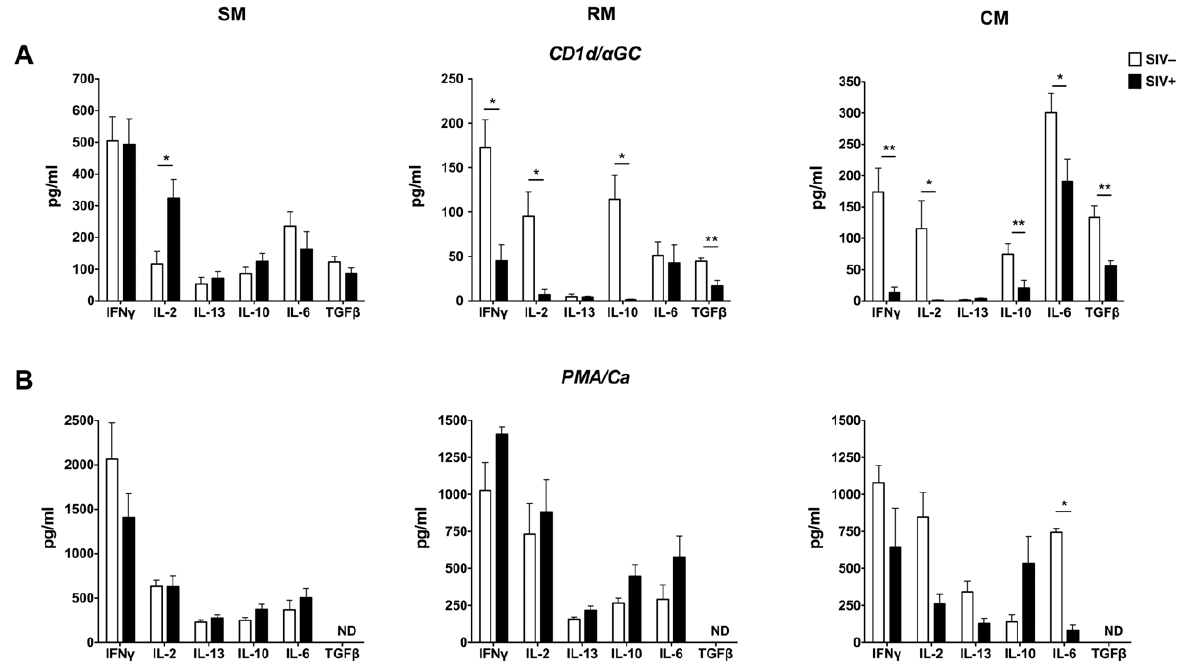
Figure 5. NKT cell hypo-function in SIV-infected macaques. Amounts of IFN- c , IL-2, IL-13, IL-10, IL-6, and TGF- b production in culture supernatants collected 24 h following in vitro stimulation of PBMC from SIV-negative and SIV-infected SM, RM and CM with (A) CD1d/ a GC and (B) PMA/Ca ionomycin. Open bars denote mean values of cytokines secreted from SIV-negative animals (n= $ 6) and filled bars denote mean values of SIV-infected animals (n= $ 4) from each species. Error bars denote SEM. * P , 0.05, ** P , 0.01 Mann-Whitney U test.